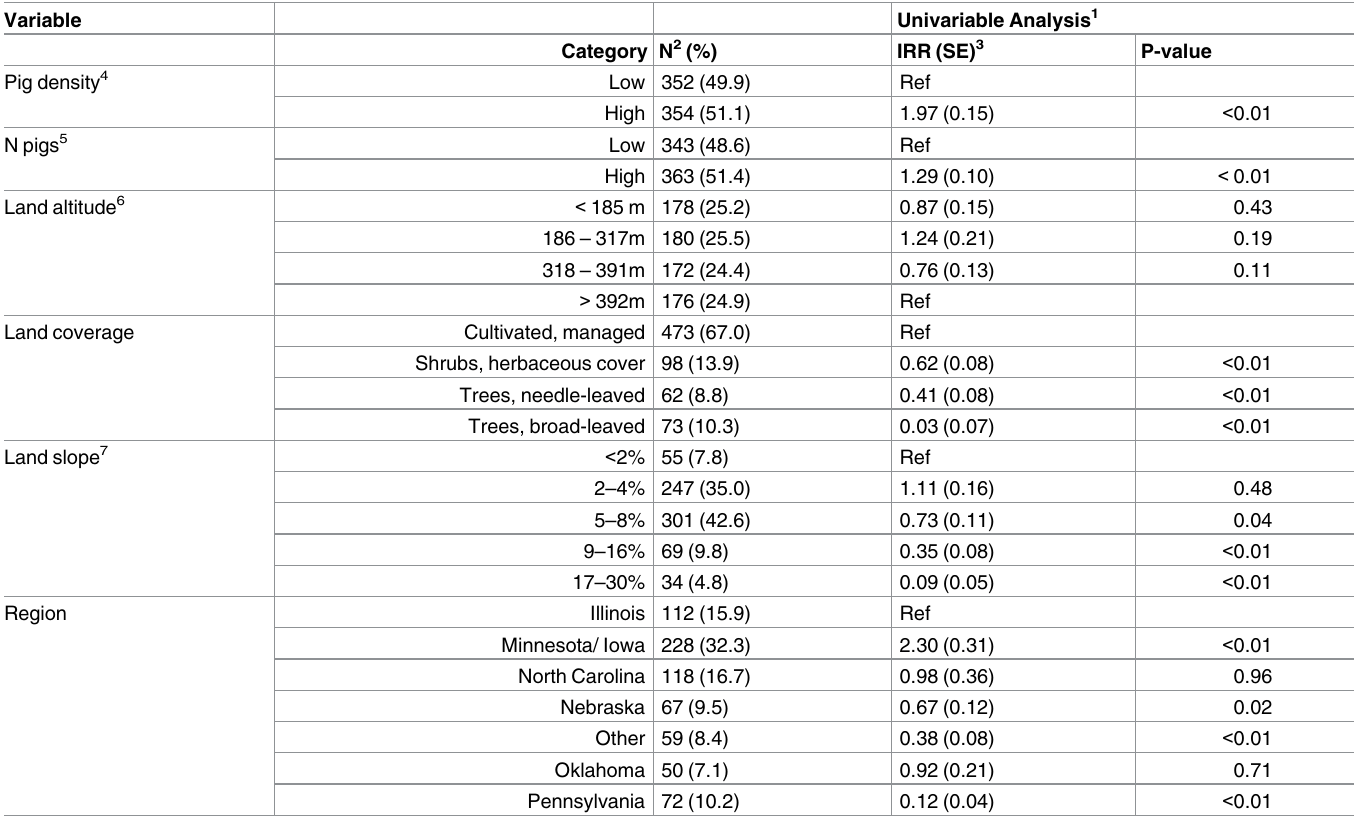
1 Generalized mixed Poisson models accounted for clustering of swine sites within production systems using a random effect 2 Number of swine sites within each category 3 Incidence rate ratio (standard error) 4 Categorized in the median (46 pigs/km 2 ) 5 Categorized in the median (2500 pigs/site) 6 Land altitude measured in meters above sea level, categorized in quartiles 7 Land inclination, measured in % or